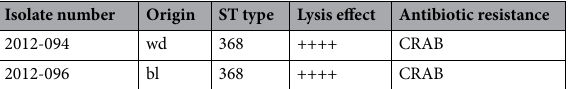
Table 1. Host-range of Abp95. The classified is according to the size of abp95 plaque; +: sensitive(1–3 mm) ++: General sensitive (3–6 mm) +++: Particularly sensitive (6–9 mm) ++++: Extremely sensitive(> 9 mm).